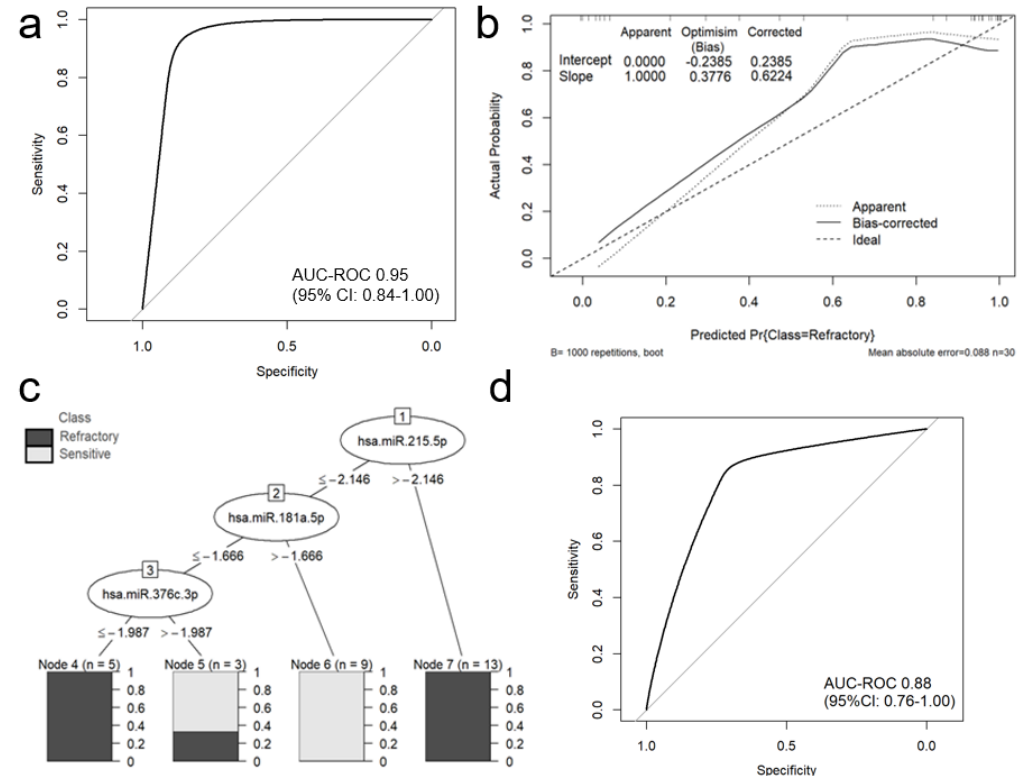
Figure 2. The performance of a classification miRNA-based model in predicting refractoriness to bortezomib-based treatment in MM patients. The area under the ROC curve for logistic regression model was estimated as 0.9474 (95% CI: 0.8421-1.000) ( a ). Calibration plot of the mi-RNA-based logistic regression model, including the apparent and bias-corrected measures by bootstrapping ( b ). In the calibration plot, the predicted probability of the model is represented on the x -axis and the observed proportion of refractoriness to bortezomib-based treatment is represented on the y axis. The 45° line indicates perfect congruity between the predicted probability and the observed proportion of bortezomib refractoriness. J48 decision tree with completely accurate (100%) model, separating refractory to bortezomib and sensitive MM patients ( c ). ROC analysis for 10-fold cross-validation ( d ).